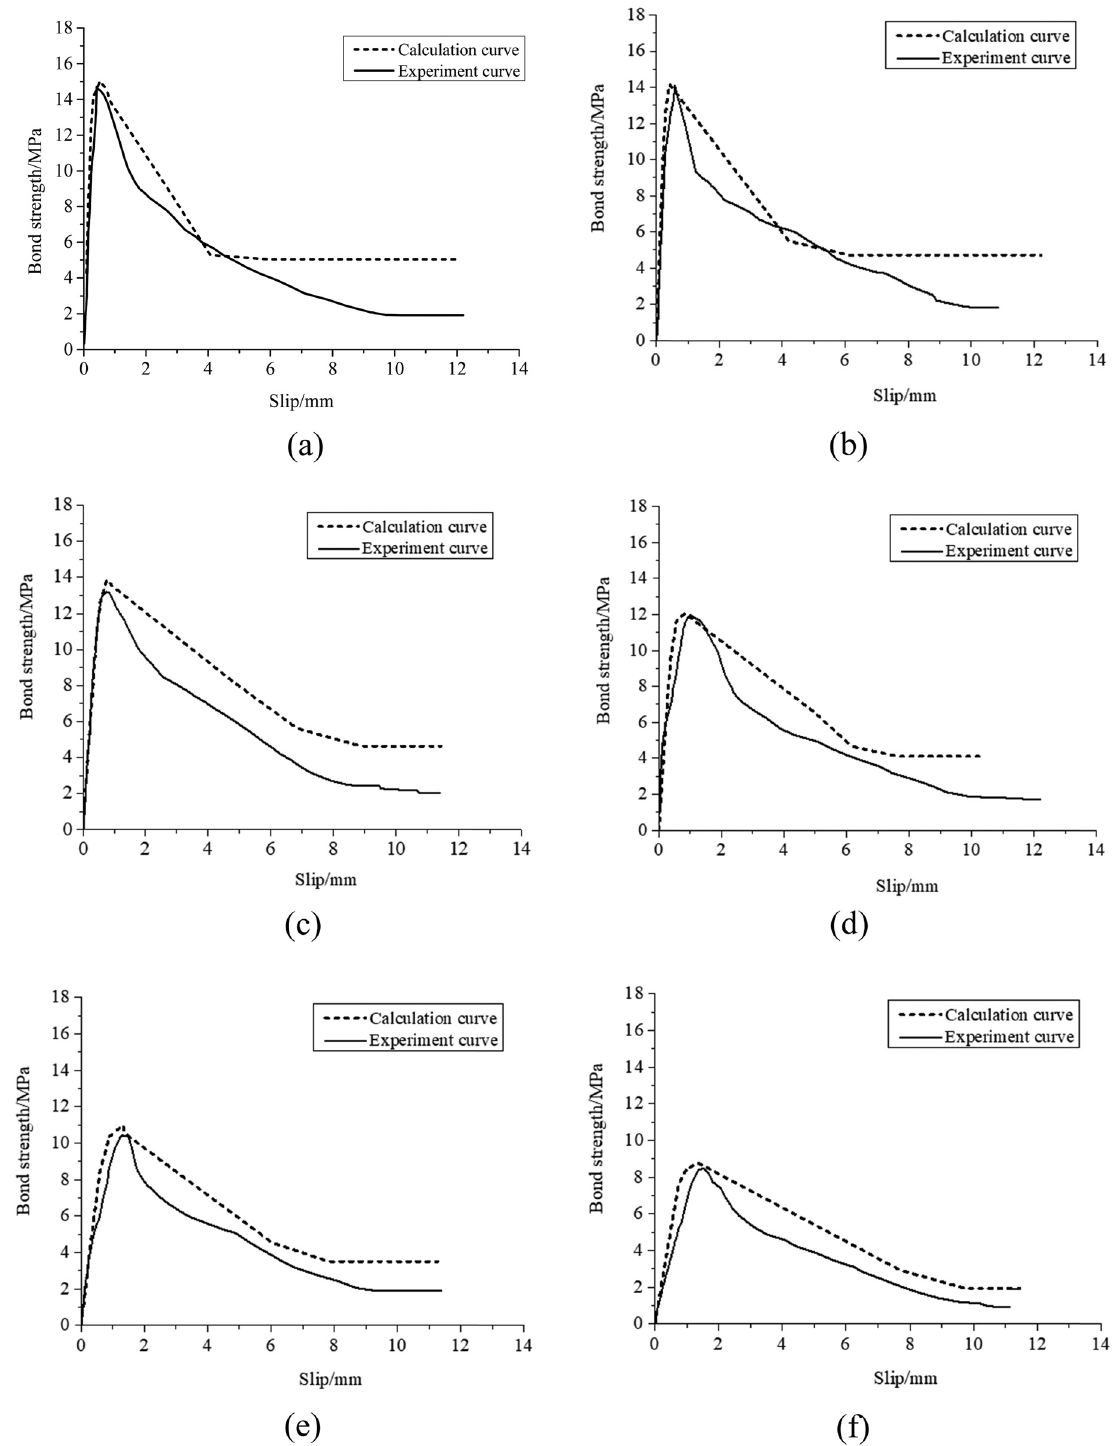
Figure 2: Comparison of calculation results and experiment results: ( a ) 0 cycle of salt frost, ( b ) 25 cycles of salt frost, ( c ) 50 cycles of salt frost, ( d ) 75 cycles of salt frost, ( e ) 100 cycles of salt frost, and ( f ) 125 cycles of salt